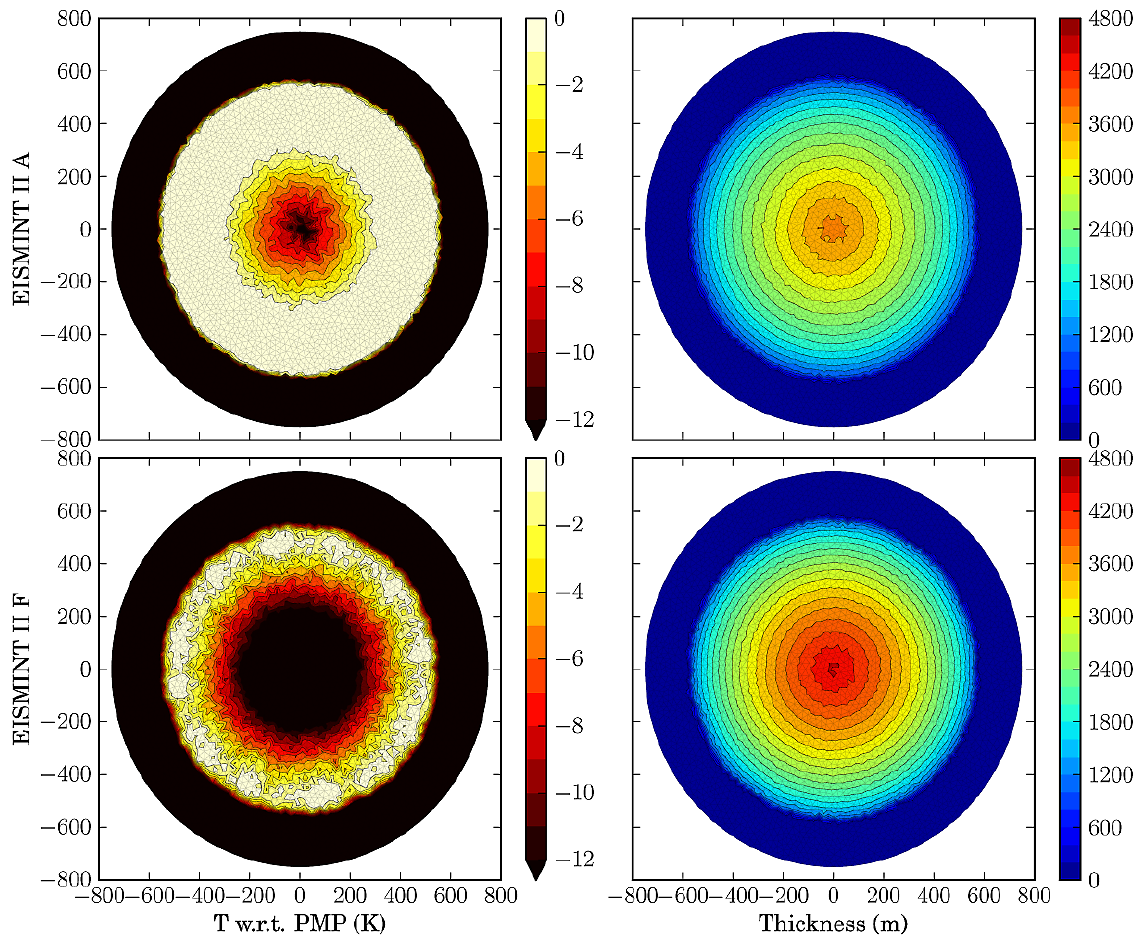
Fig. 10. Thickness and basal temperature fields for EISMINT II A and F at 200ka.